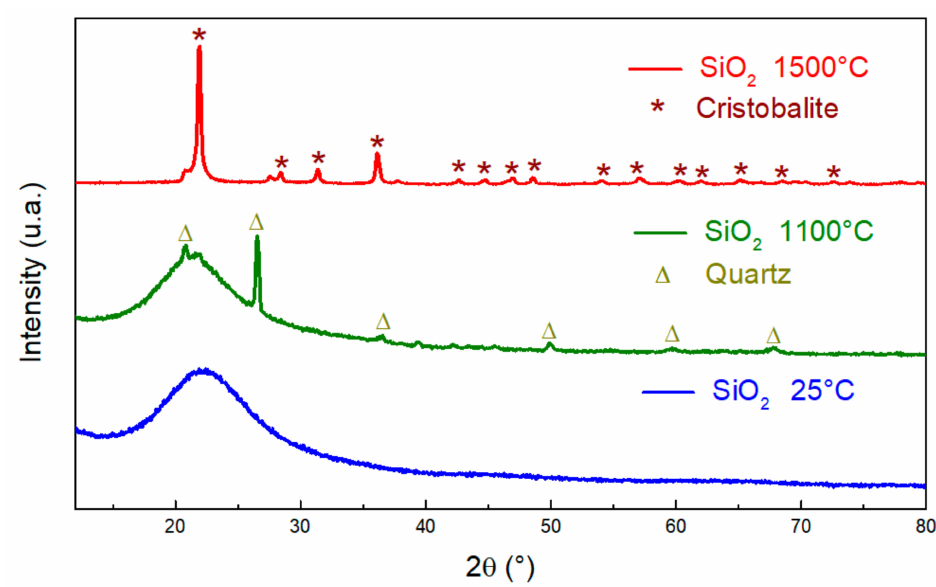
Figure 6. XRD patterns of SiO 2 before (blue) and after thermal treatment at 1100 ◦ C (green) and 1500 ◦ C (red).